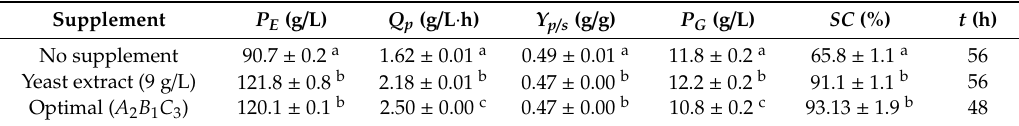
Table 3. Fermentation parameters of ethanol fermentation from the sweet sorghum juice with and without nutrient supplements.